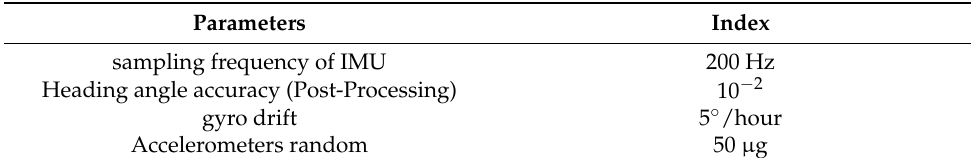
Table 1. The critical parameter indices of sub IMU.